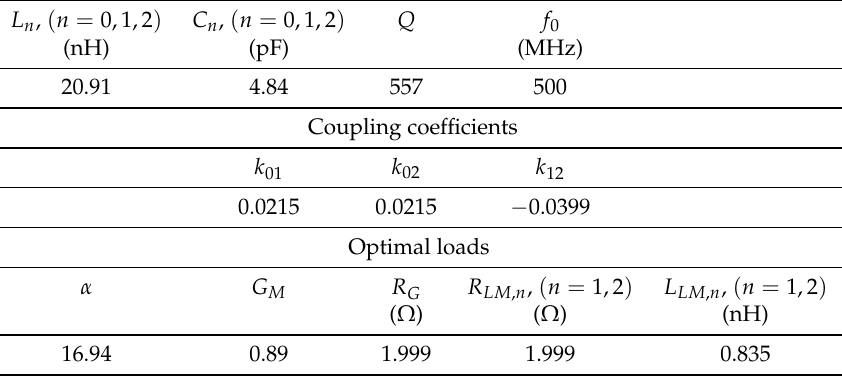
Table 1. Parameters of the equivalent circuit and optimal loads of the WPT link illustrated in Figure 5a (Case 1).